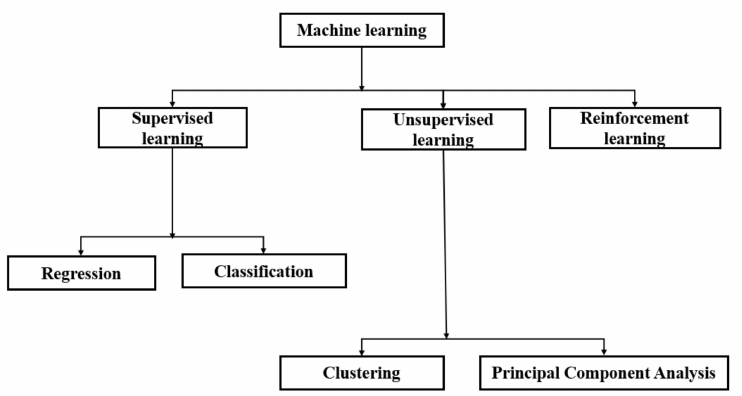
Figure 1. Classification of machine learning